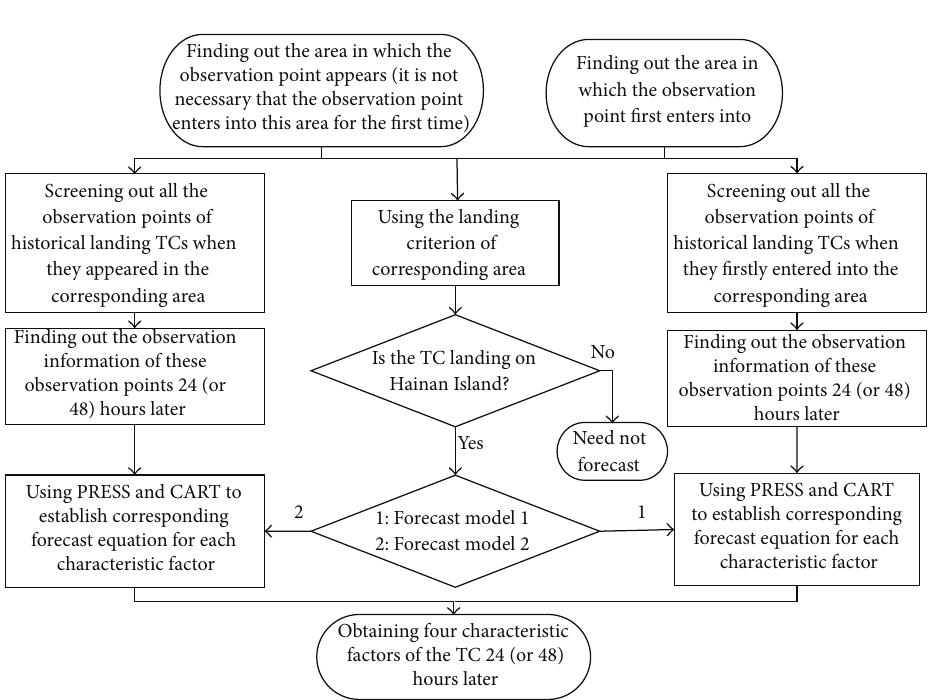
Figure 8: Flow diagram of dynamic prediction